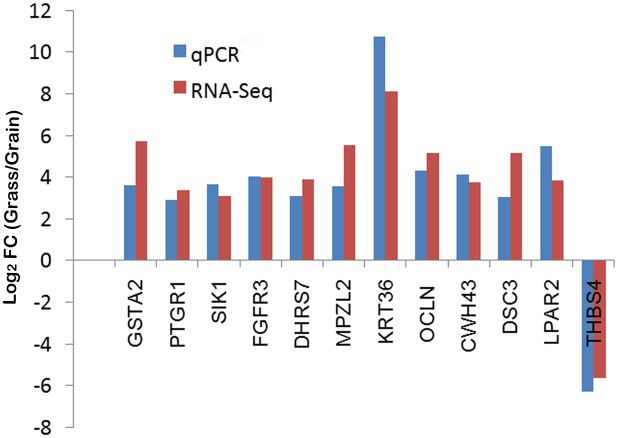
Validation of differentially expressed genes.The mean value of log2 (fold-change) for each group was compared in the bar chart for the 12 selected genes. qPCR data was normalized by GAPDH expression for each sample. Means of significant (FDR≤0.1) fold changes were computed for qPCR and DESeq using sample from the same 4 animals in each analysis. FC means fold-change.